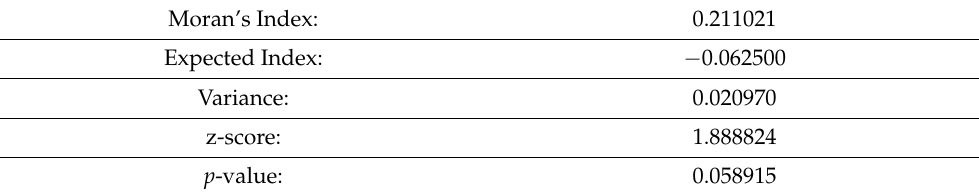
Table A2. Moran’s